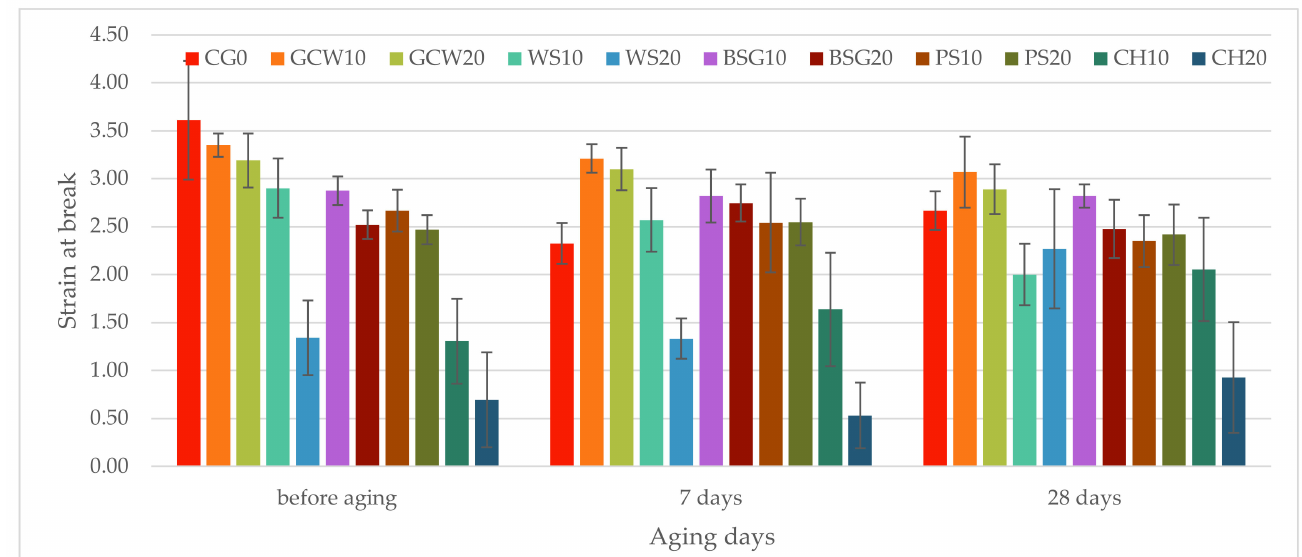
Figure 10. Materials’ strain at